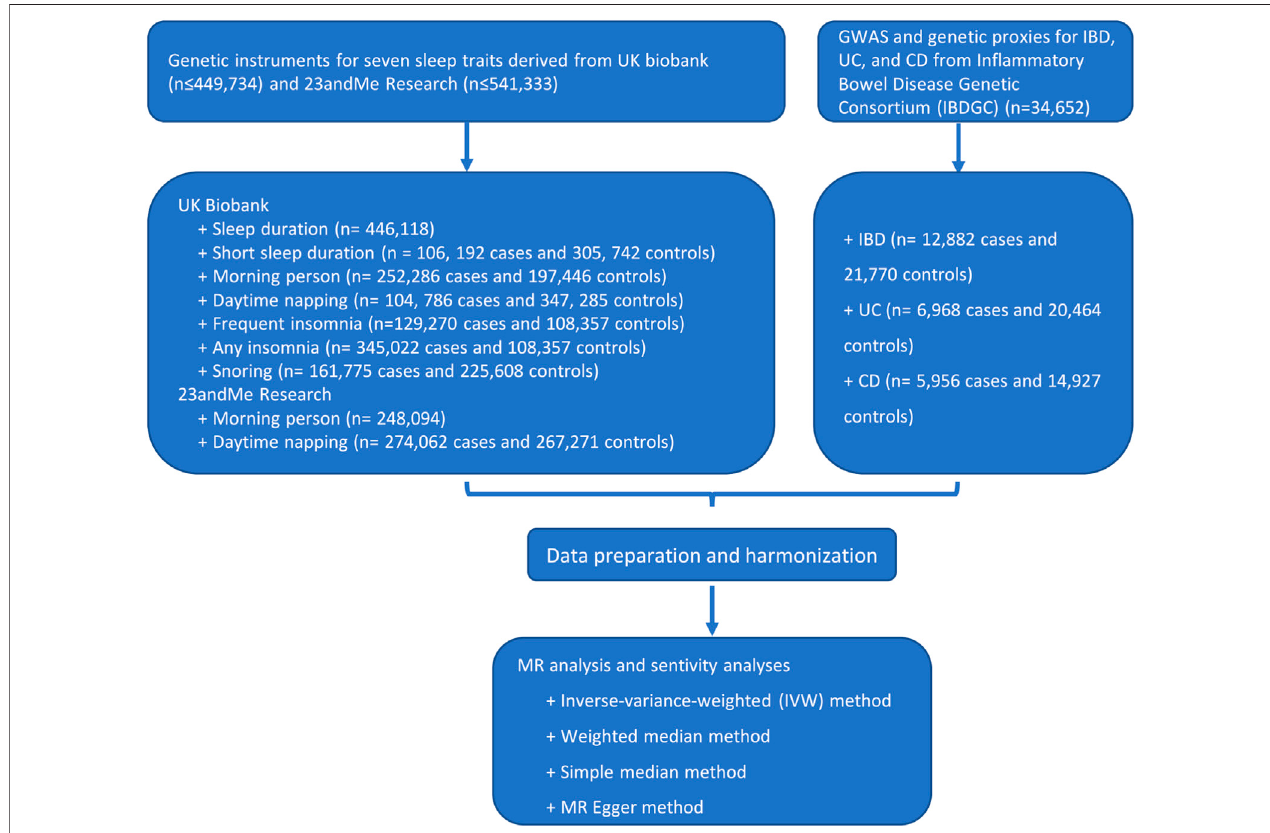
FIGURE 1 | Flowchart of the study process. Abbreviations: GWAS, genome-wide association studies. IVW, inverse-variance weighted. MR, Mendelian randomization. Annotation: UK Biobank is a large-scale biomedical database and research resource, containing in-depth genetic and health information from half a million UK participants. The 23andMe cohort is one of the largest re-contactable research databases of genotypic and phenotypic information.